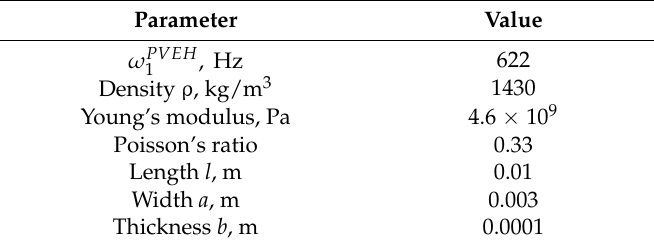
Table 1. Mechanical and geometrical properties of the proposed Piezoelectric Vibration Energy Harvester.